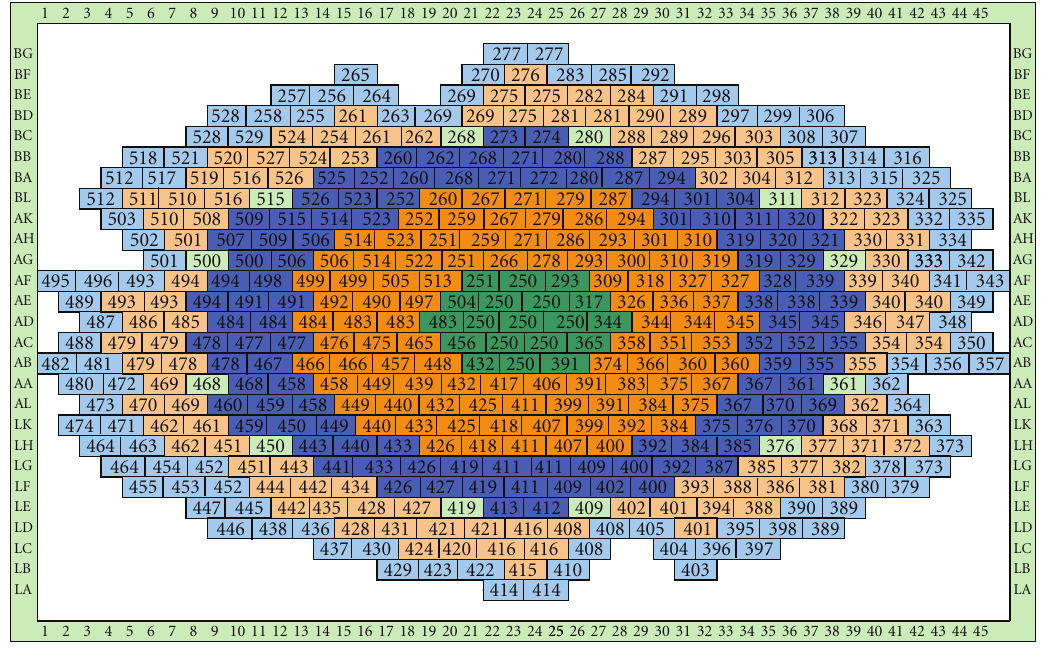
Figure 3: Fuel burnup zones and RELAP5-3D fuel channels distribution, [1].